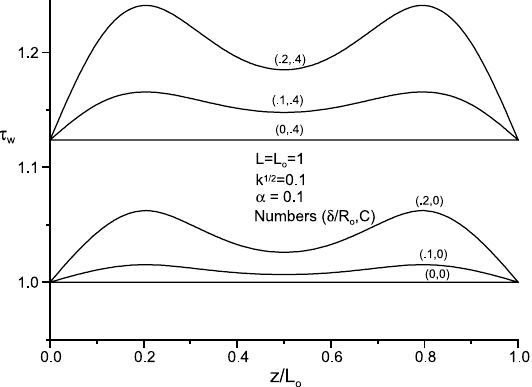
Fig. 6. Impedance, λ versus C for different stenosis height, δ/ R o .